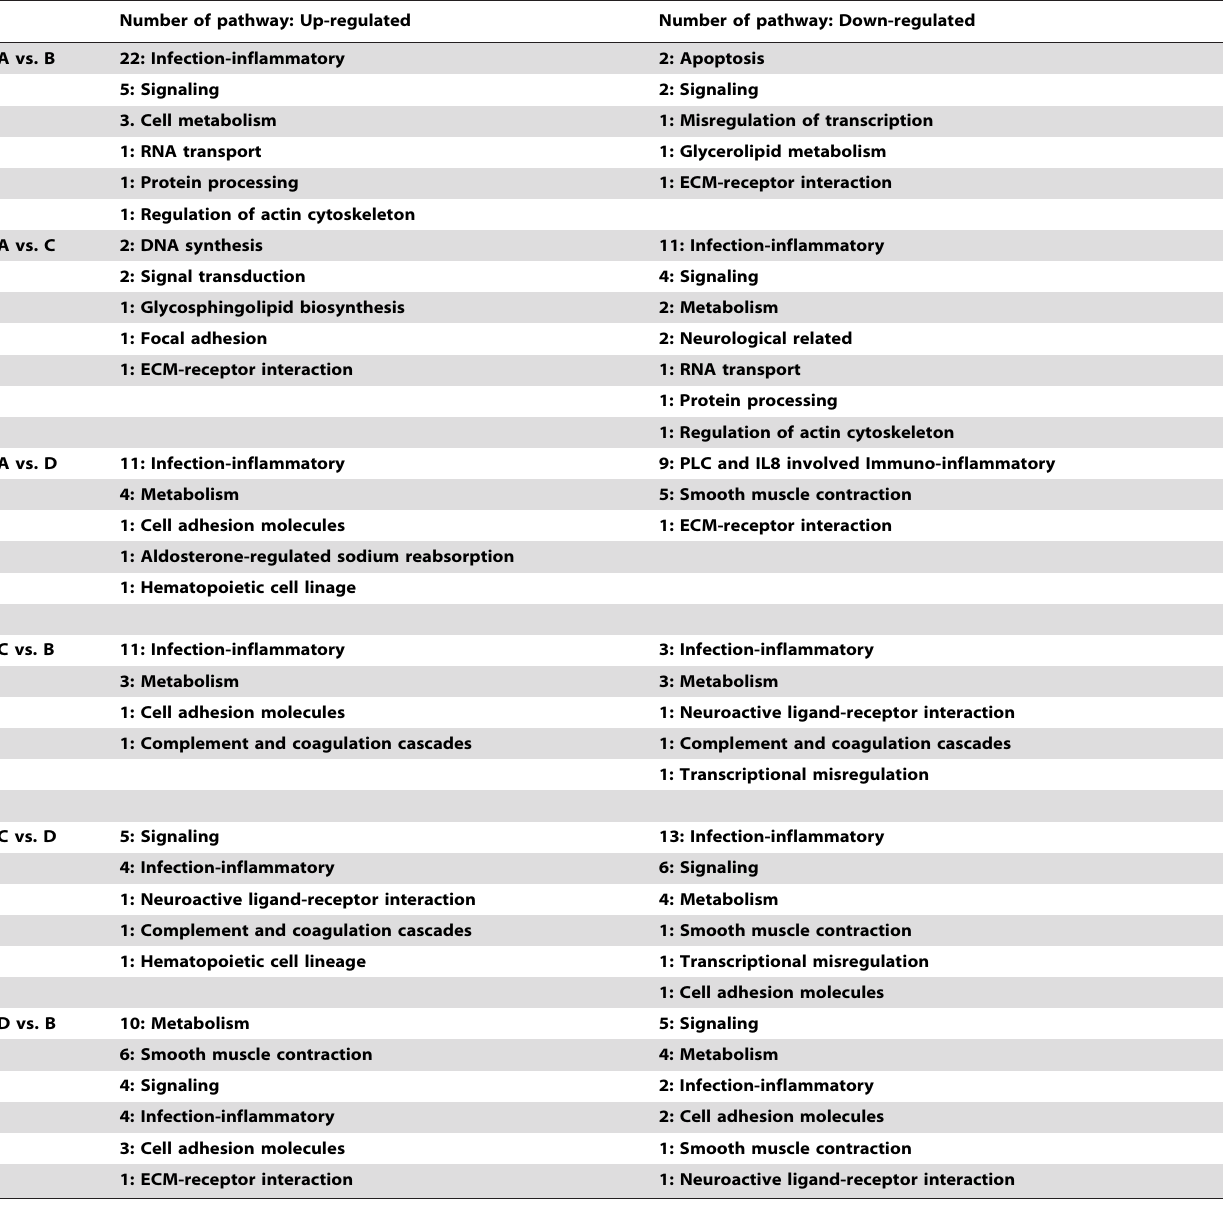
Number of pathway: Up-regulated